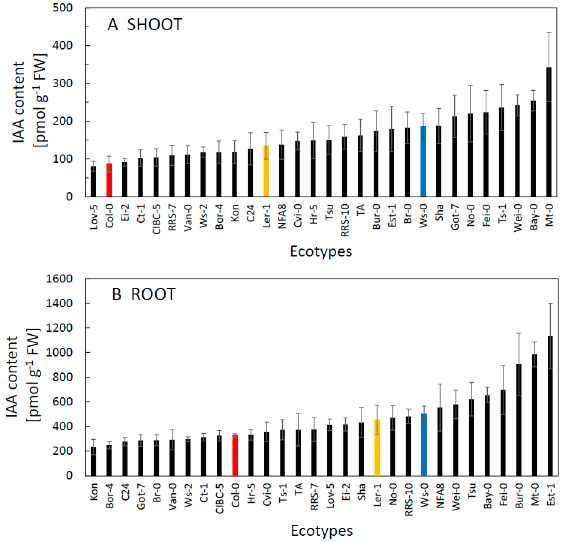
Figure 2. The content of IAA in the shoot ( A ) and root ( B ) of thirty A. thaliana ecotypes grown 21d in controlled conditions. Commonly used ecotypes are marked in colour (Red = Col-0, Blue = Ws-0, Orange = Ler-1). See Table 1 for the full list of ecotypes. Means ± SD.